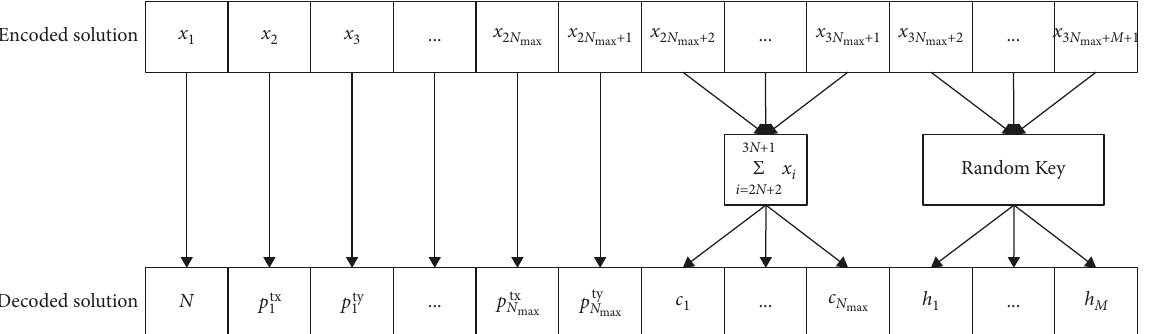
Figure 3: Unconstraint encoding/decoding scheme